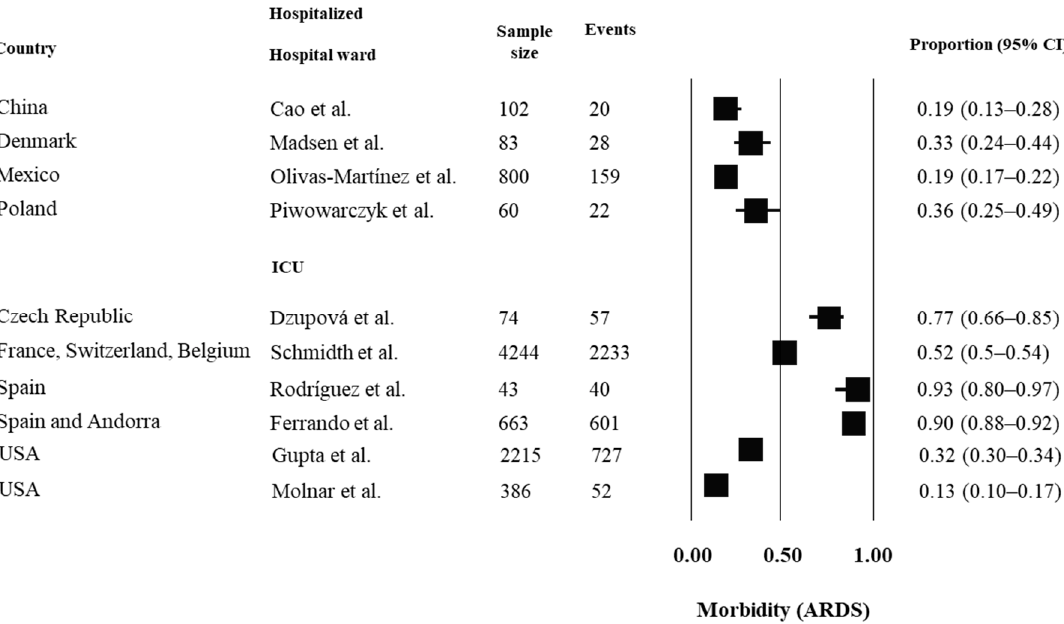
related to MOFS, occurrences ranged from 8% to 32% across studies in hospital wards and from 6% to 22% in ICU.